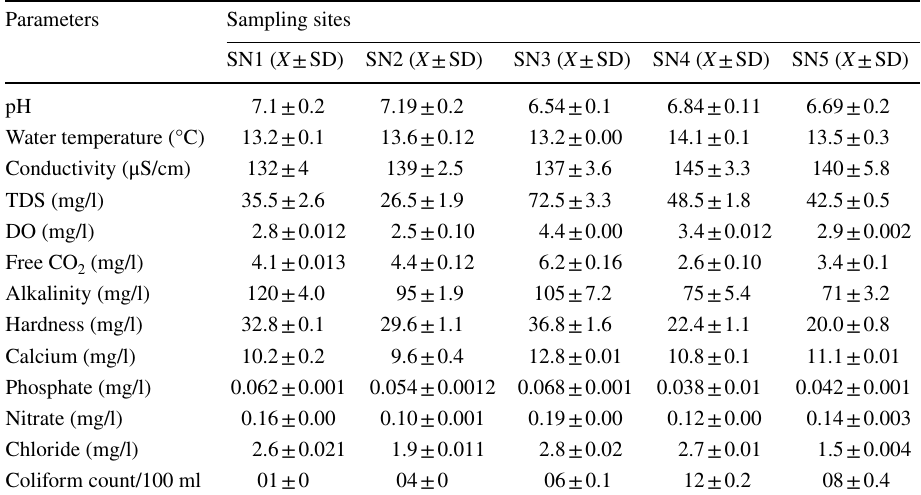
Table 3 Water quality parameters of water samples collected from study